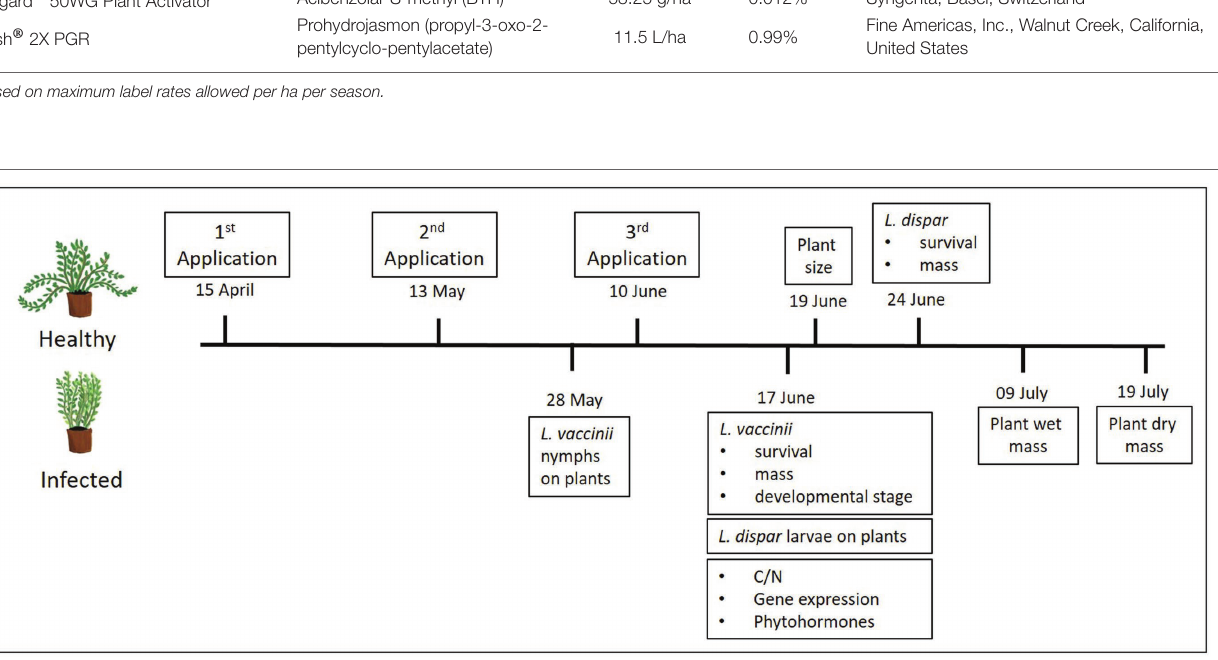
Gypsy Moth ( Lymantria dispar ) To determine the interactive effects of phytoplasma infection and elicitor treatments on plant carbon (C) and N, all vines were taken from three randomly selected plants from each infection/treatment combination on June 17, 2019 ( Figure 1 ; n = 2 infection levels × 5 treatments × 3 replicates = 30 plants). Vines from each plant were kept in separate paper bags and allowed to dry. The dried samples (1.5 g) were weighed using a Mettler Toledo AE 50 analytical balance and then analyzed for total C and N by combustion with an Elementar Vario Max N/C analyzer (Pella, 1990; Horneck and Miller, 1998) by the Penn State University Agricultural Analytical Service Laboratory. 1 Percent N and C/N ratios are reported based on plant sample dry mass.